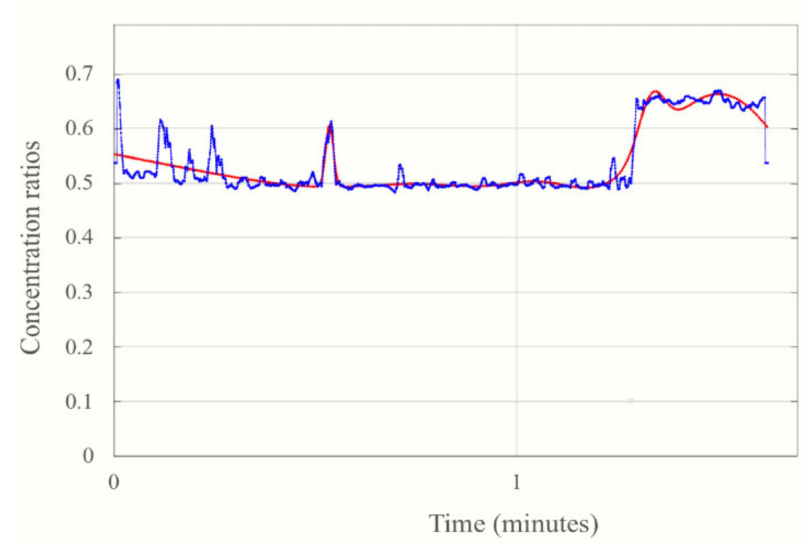
Figure 14. CRF value for alumina at flow rates of 7 × 10 − 3